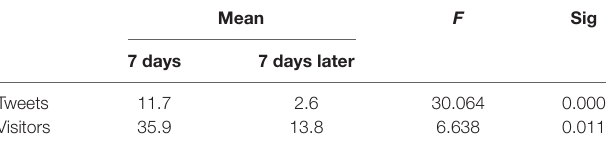
Table 4 | One-way ANOVA.